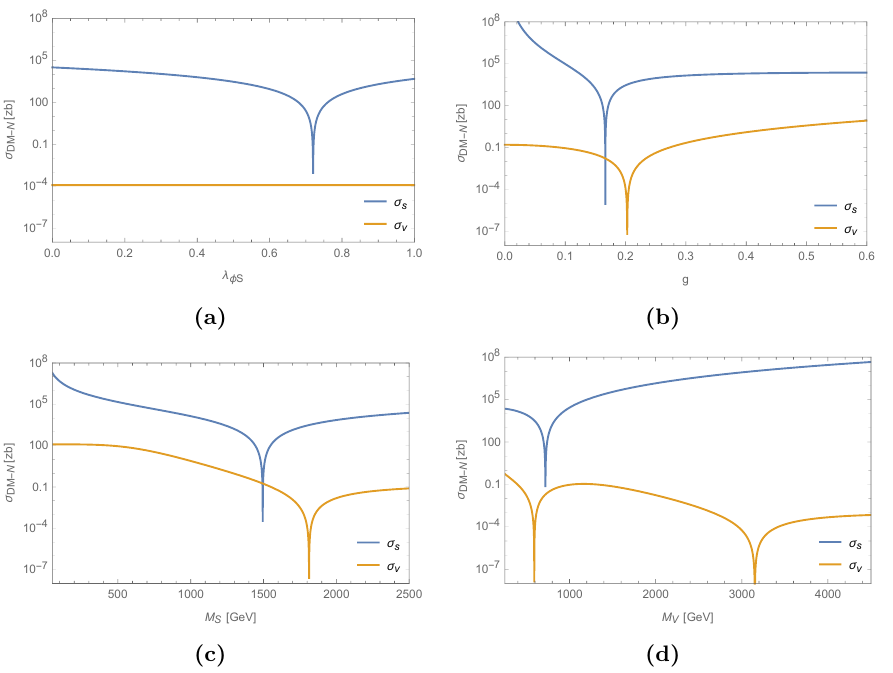
Figure 5. Variation of DM-Nucleon spin-independent cross section respect to parameter space. In all digrams the fixed parameters are: M